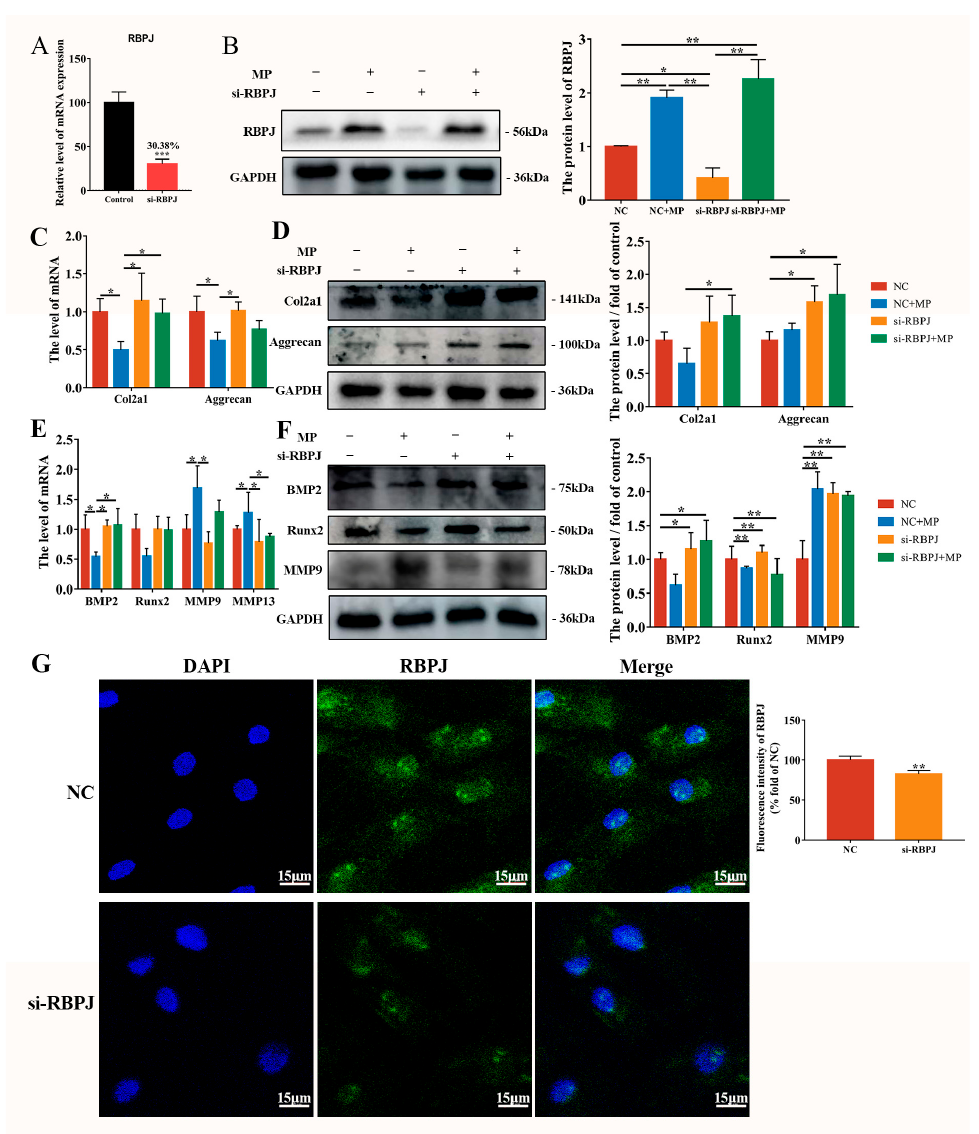
Figure 5. MP-induced alterations in BMSCs differentiation are mitigated by si-RBPJ. ( A ) The transfec- tion efficiency of si-RBPJ; ( B ) effect of si-RBPJ on RBPJ protein expression level in BMSCs. ( C , D ) Effects of si-RBPJ on the expression levels of Col2a1 and Aggrecan genes ( C , E ) and proteins ( D , F ) related to bone metabolism and cartilage metabolism in BMSCs. ( G ) RBPJ expression stained with Alexa Fluor 488 fluorescence (green) was visualized by immuno-fluorescence, and nuclei were stained with DAPI (blue). Scale bar = 15 µ m. * p < 0.05 were considered statistically significant and ** p < 0.01 means extremely